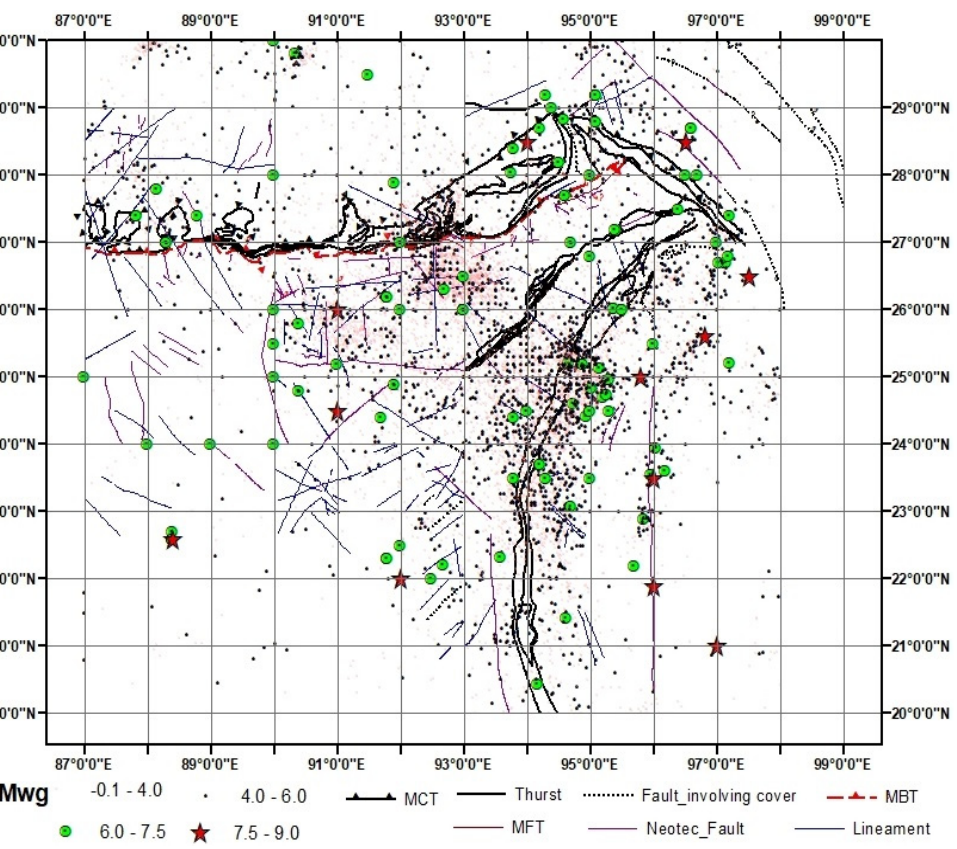
Figure 1. Seismotectonic map exhibiting seismicity for M wg ≥ 2 with epicenters and tectonic charac- teristics of the NE India region on a GIS platform.